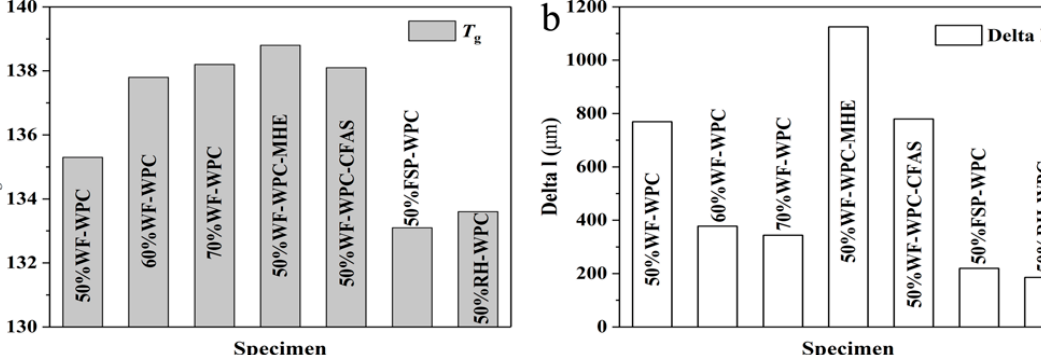
Figure 3. Illustrating of the calculation of the deformation step heights of glass transition (Delta l, a ) and the curves of dL versus temperature ( b ) acquired through TMA testing.